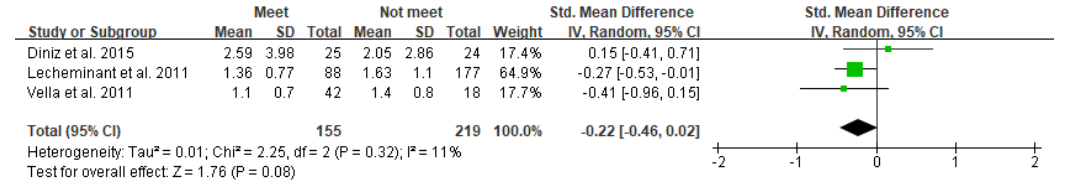
Figure 3. Forest plot of the effect of meeting physical activity guidelines on HOMA-IR. Overall pooled effect for random effects model represented by black diamond.